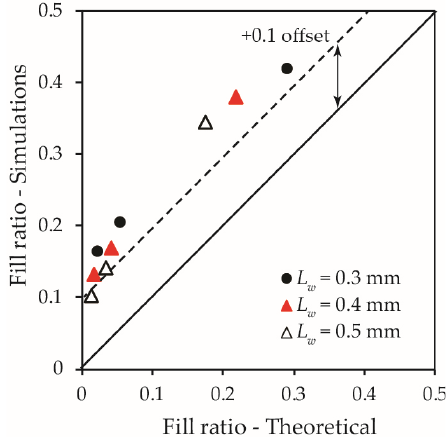
Figure 14. Comparison of the simulation results obtained from numerical modelling to those from theoretical data (Zhang and Qian [21]).